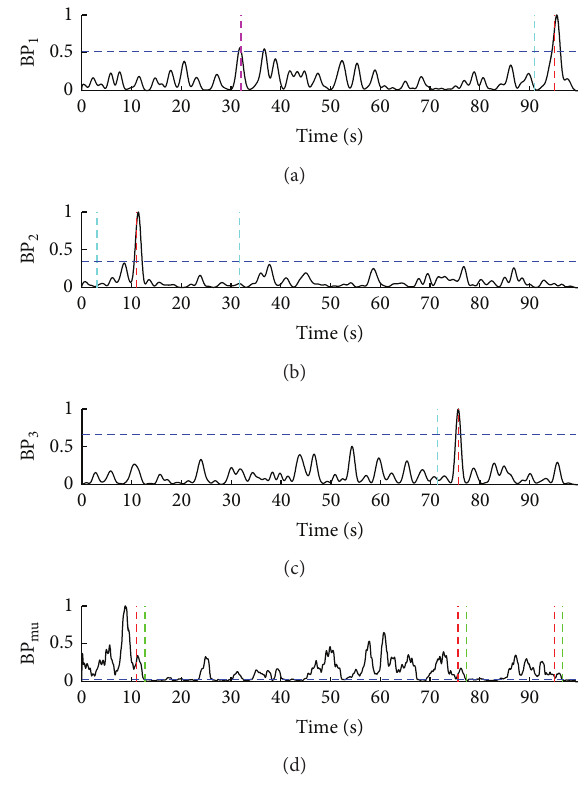
Figure 5: Normalized band-powers BP 1 , BP 2 , BP 3 , and BP mu from (a) to (d). Three successful trials (TP), one per each LED, and one false activation of SSVEP-BCI (FP ssvep ) for subject S5, during the representative 100-second interval are presented. (a)–(d) arrangement and color codes for turquoise, red, blue, and green are the sameas in Figure 4. Pink vertical dotted line marks one incorrect SSVEP detection when subject focused and reached for the second object (LED 2 ), but SSVEP 1 were falsely detected (threshold TH 1 was exceeded by BP 1 for DT 𝑠